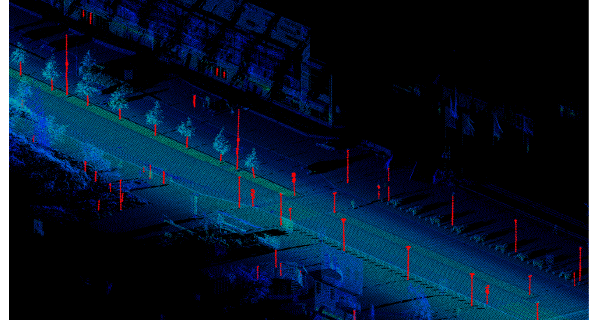
Figure 5. A view to the MLS data of the EuroSDR project (small bluish-green dots) including extracted poles and tree trunks (larger red